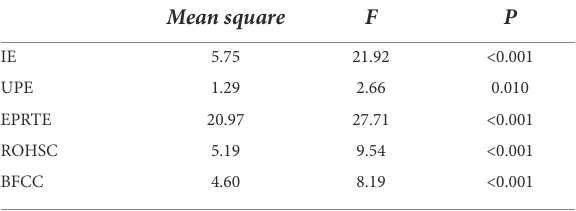
TABLE 4 Gender by BMI category interaction statistics on all variables of interest. Mean